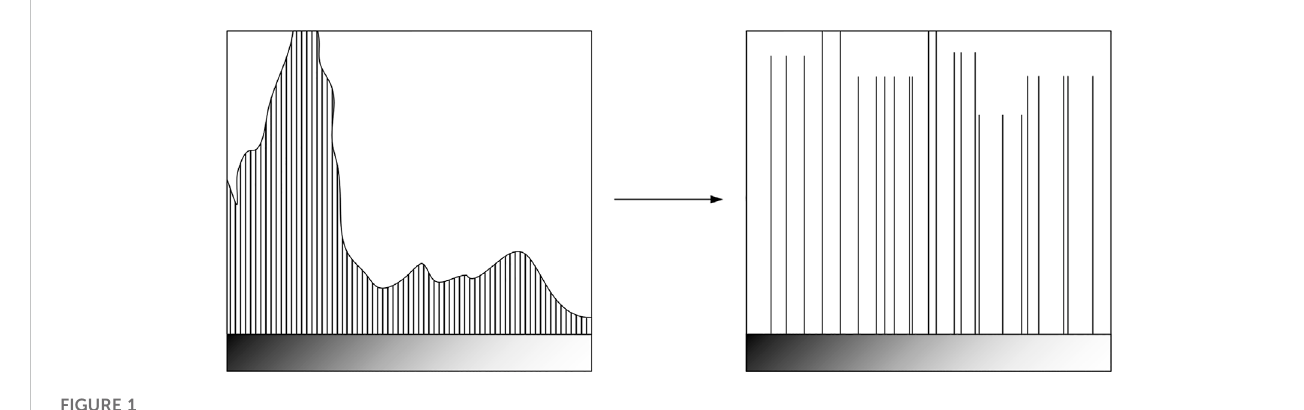
FIGURE 1 Histogram change.